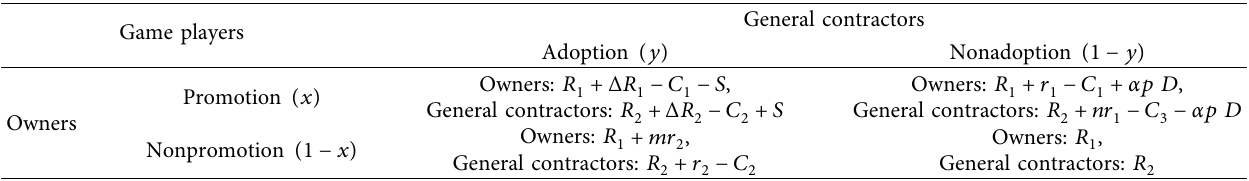
Table 2: Game payoff matrix.